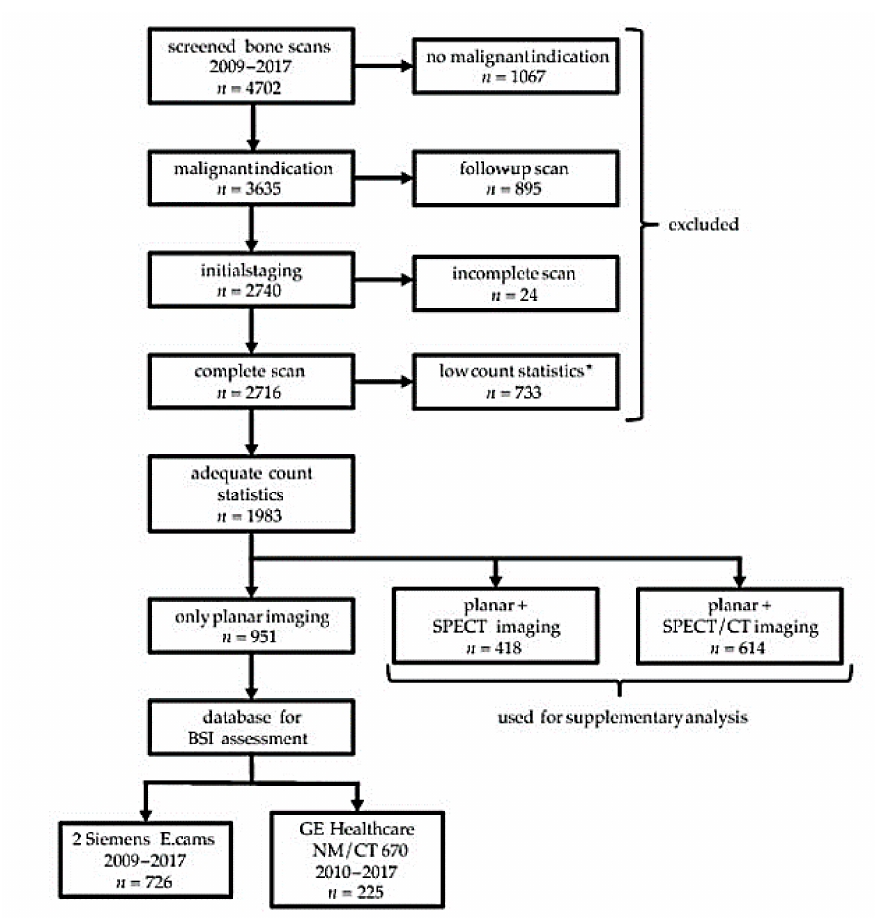
Figure 1. Patient selection for analysis. Note: * excluded from analysis due to an insu ffi cient count statistic ( < 1 million counts in geometric mean images) to comply with methodological constraints of the BSI algorithm, CT = Computer Tomography, BSI = Bone Scan Index, SPECT = Single Photon Emission